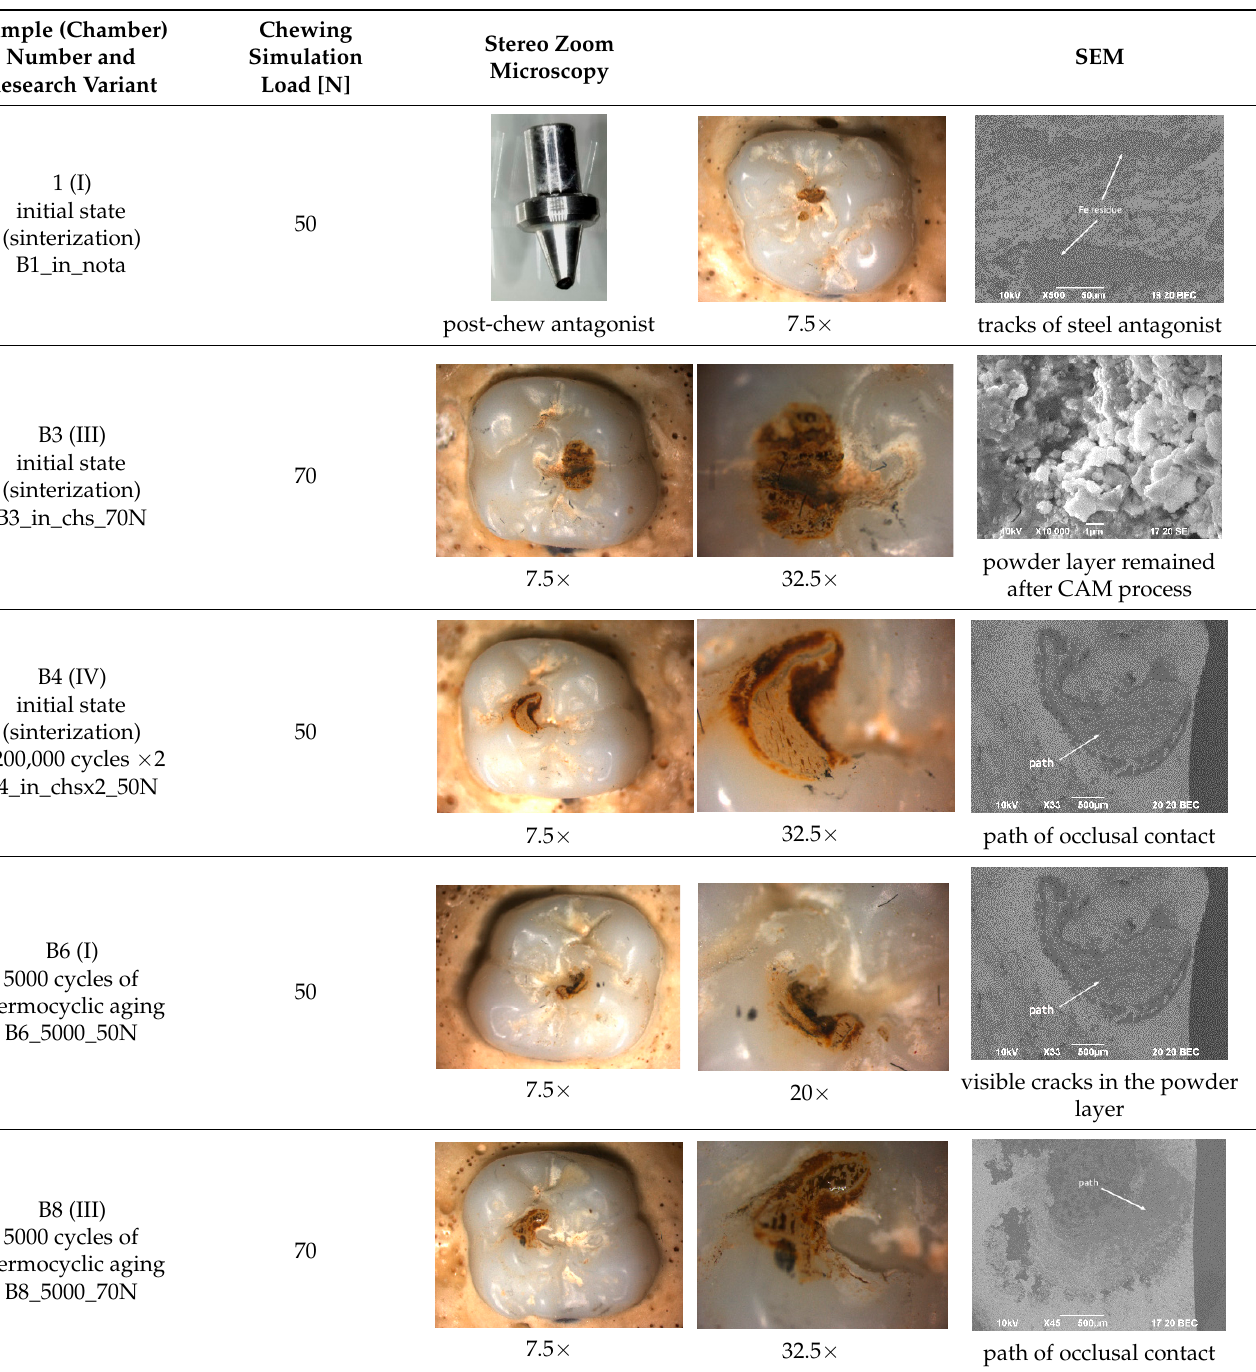
lapped and polished with a 15 µm, 6 µm, and 1 µm diamond. After that, a non-crystalizing